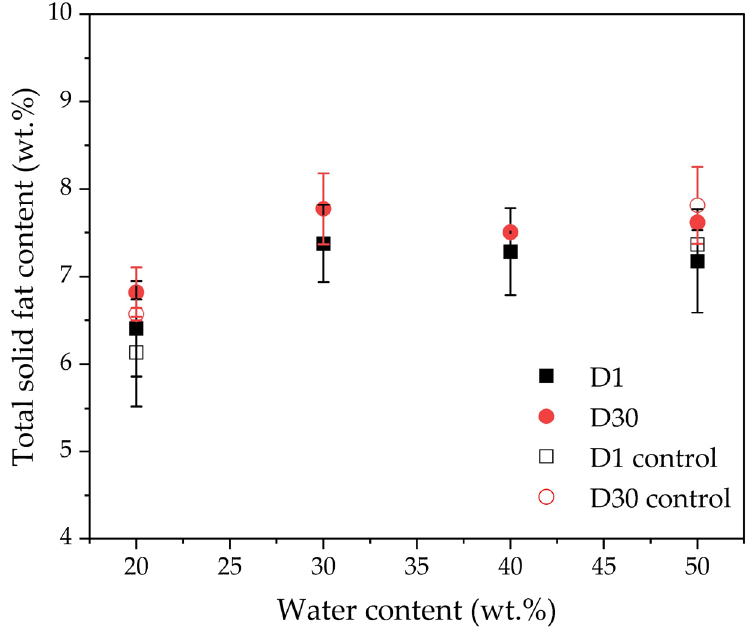
Figure 8. The solid fat content of water-in-oil emulsions on day 1 (D1) and day 30 (D30). Control emulsions were prepared without any LMP in the aqueous phase.